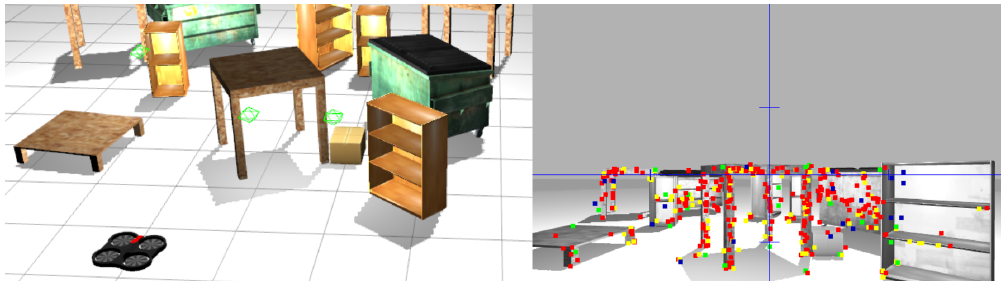
Figure 7. World Scene of Gazebo used for simulation and the camera